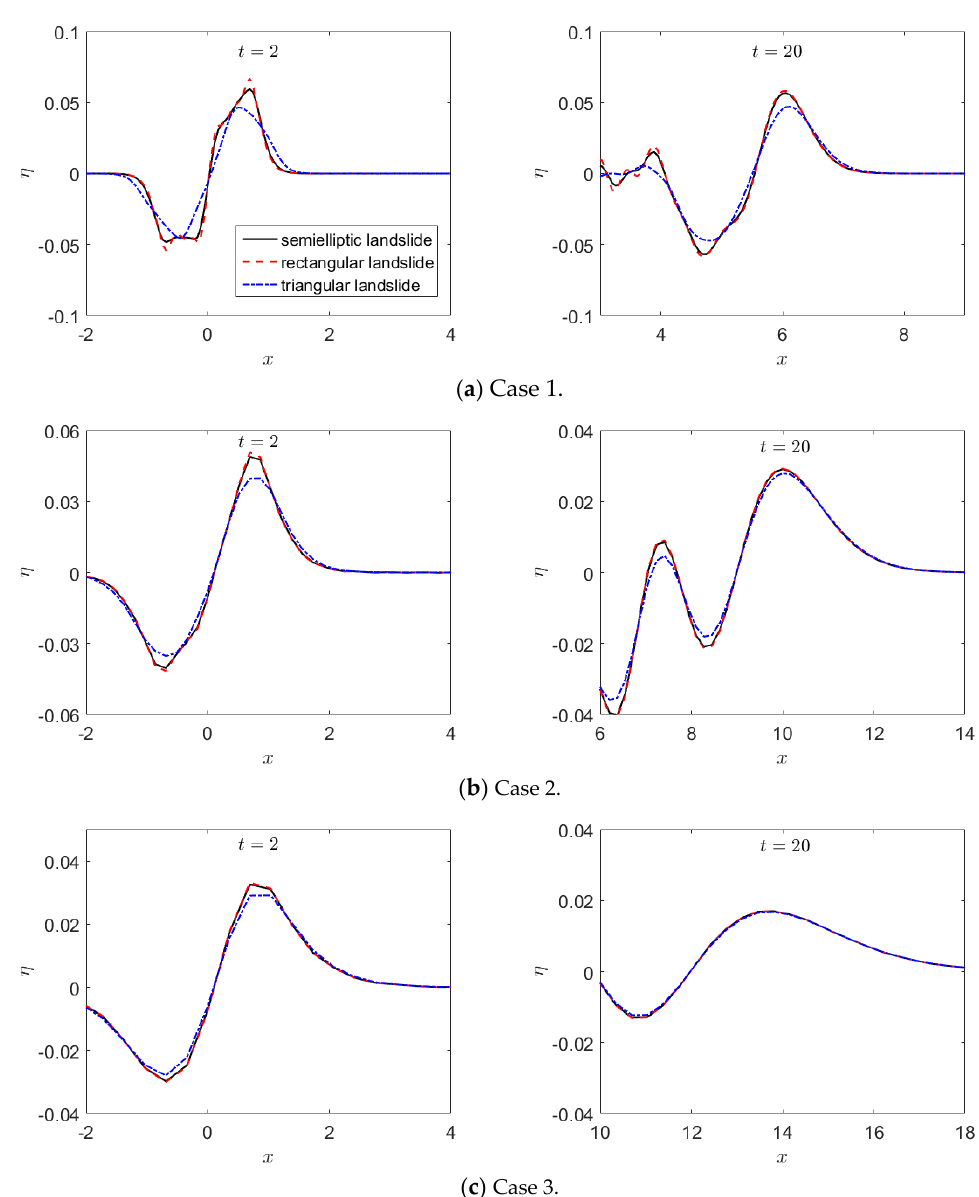
Figure 3. Comparisons of water waves generated by landslides with three different shapes ( Fr = 0.1, LFD model).